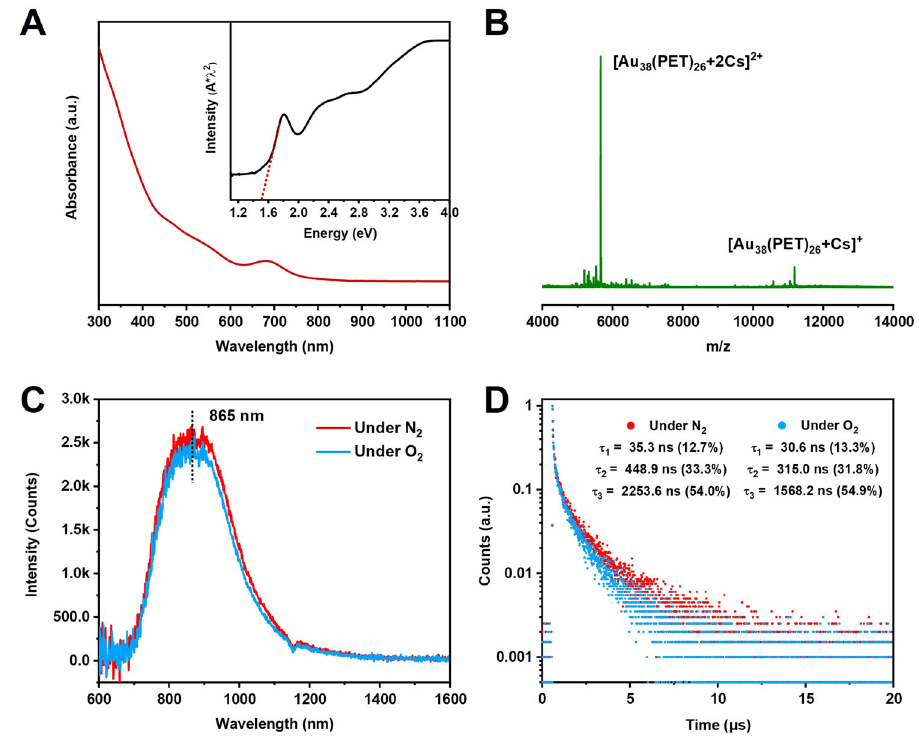
Fig. 1 Mass spectrum and optical characterization of Au 38 (PET) 26 . A UV-Vis absorption spectrum of Au 38 (PET) 26 in dichloromethane (DCM). The inset shows the absorption spectrum on the photon energy scale. B ESI mass spectrum of Au 38 (PET) 26 . C PL spectra of Au 38 (PET) 26 in DCM under N 2 and O 2 , respectively. D PL decay pro fi les of Au 38 (PET) 26 in DCM under N 2 and O 2 , respectively. For PL measurements: excitation at 400 nm (slit width 8 nm), and emission slit width 8